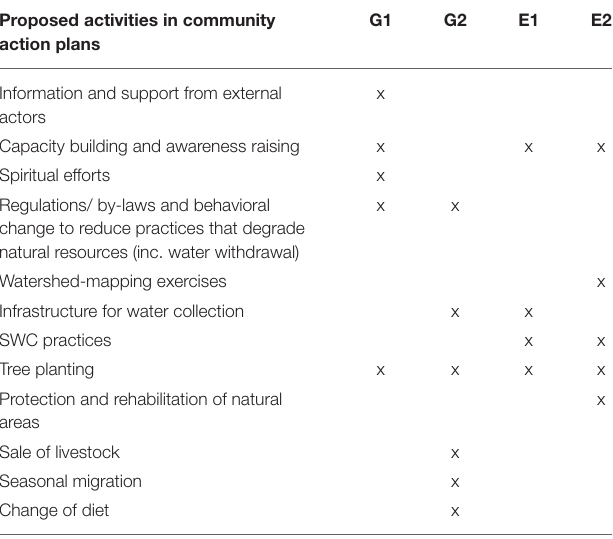
TABLE 5 | Summary of proposed natural resource management actions to build resilience in respective watershed (E1,E2,